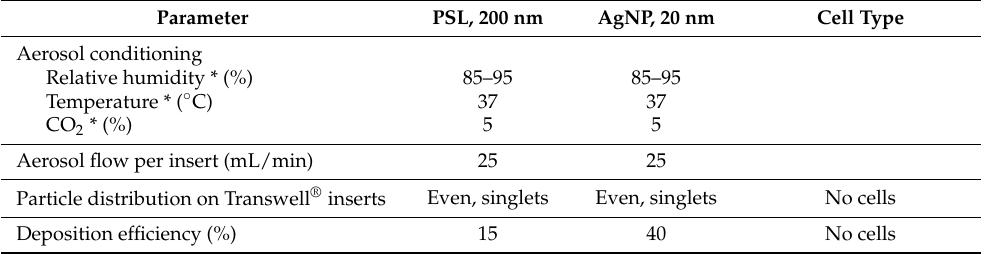
Table 1. Characterization of the Nano Aerosol Chamber for In Vitro Toxicity (NACIVT)